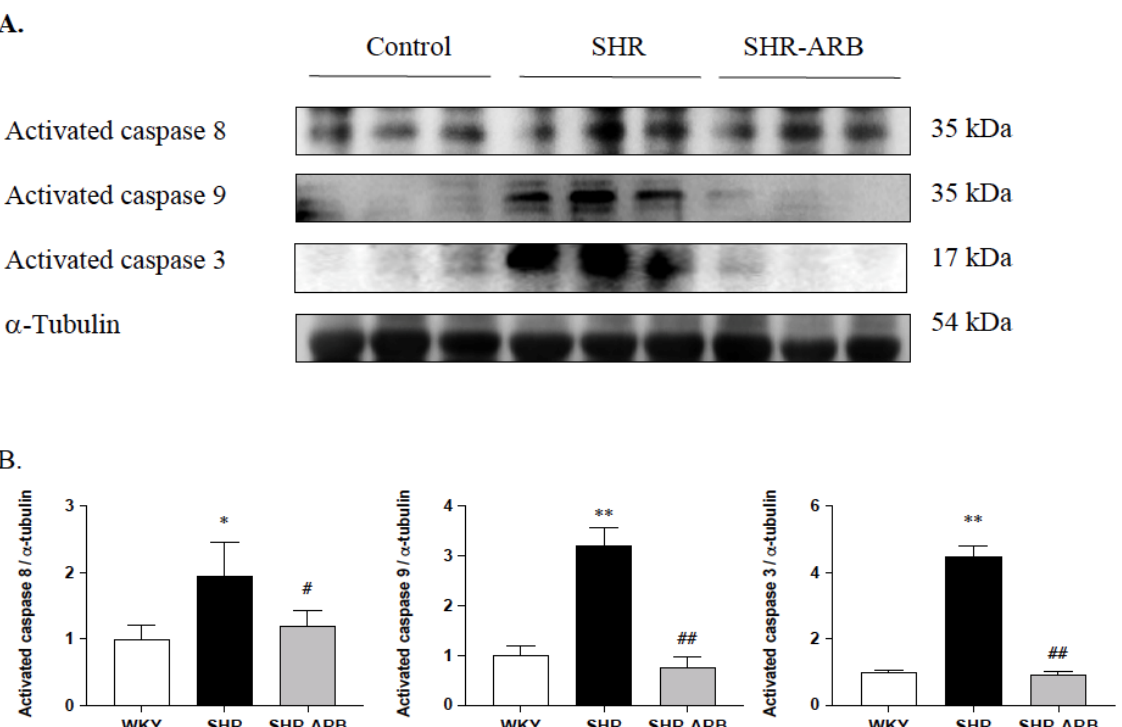
Figure 3. ( A ) The representative protein levels of caspase-8, caspase-9, and caspase-3 from the left ventricles in the normotensive group (WKY), untreated hypertensive group (SHR), and SHR rats with treated irbesartan (SHR-ARB), as measured by Western blot methods. α -Tubulin served as an internal control. ( B ) Bars indicate the relative fold changes of protein levels relative to the Control group in active caspase-8, caspase-9, and caspase-3 on α -Tubulin and mean ± standard deviation (n = 8;8;8). * p < 0.05, ** p < 0.01: significant differences from the Control group. # p < 0.05, ## p < 0.01 indicates significant differences between the SHR group and the SHR-ARB group.